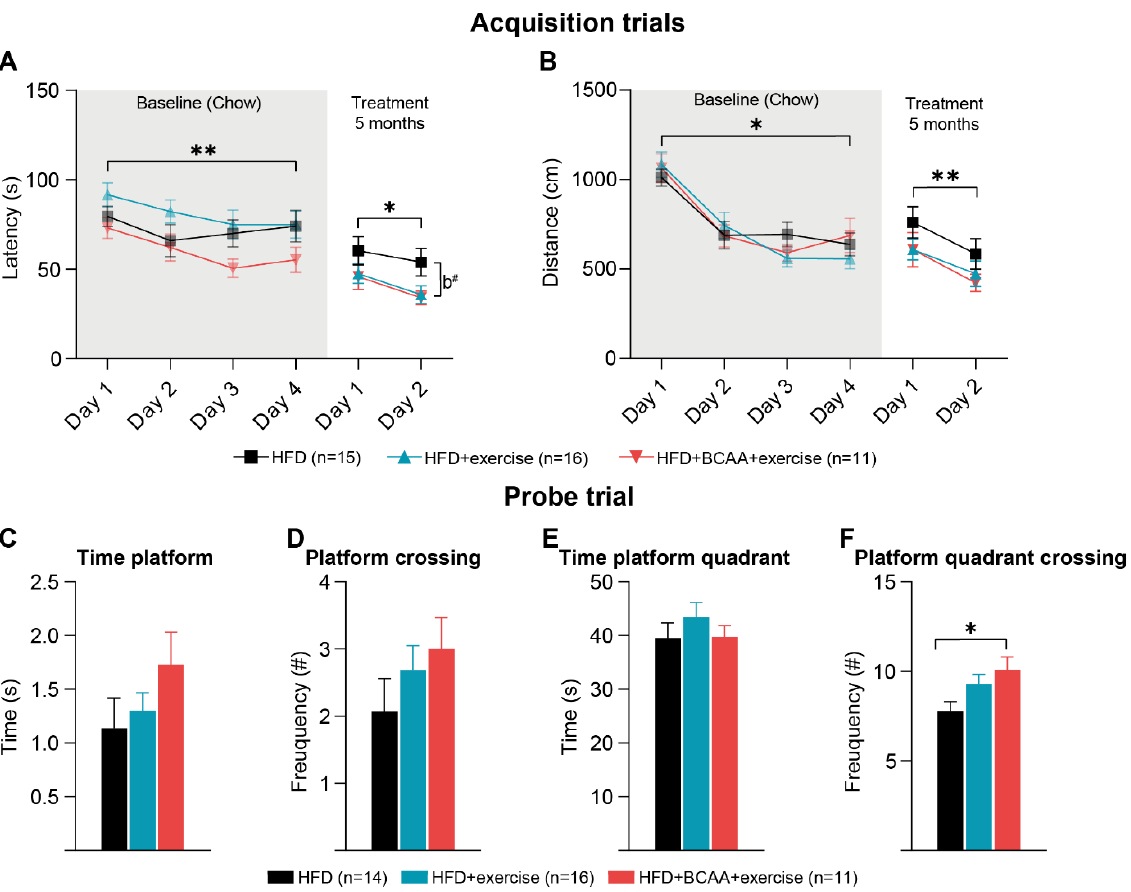
Figure 6. (Reverse) Morris water maze. Spatial learning and memory were assessed in the Morris water maze (MWM) at baseline (chow) and in a reverse MWM 5 months after allocation in treatment groups (HFD, HFD + exercise, HFD + BCAA + exercise). ( A ) During 4 constitutive acquisition days, chow-fed mice learned to find the hidden platform. After 5 treatment months, animals of all treatment groups were again subjected to an acquisition trial (2 days) with a novel platform location. The latency to find the hidden platform is indicative of spatial learning ability. ( B ) Total swim distance was measured during both acquisition phases (baseline and reverse). ( C – F ) In the probe trial of the reverse MWM, the platform was removed from the pool, and ( C ) the time spent at the former platform location, ( D ) frequency of crossing the former platform location, ( E ) time spent in the former platform quadrant, and ( F ) the frequency of crossing the former platform quadrant were measured. High-fat diet (HFD), branched-chain amino acids (BCAA). Data are presented as mean ± SEM. * p < 0.05, ** p < 0.01, # 0.05 < p < 0.08 (trend); b: difference HFD vs. HFD + BCAA + exercise group.